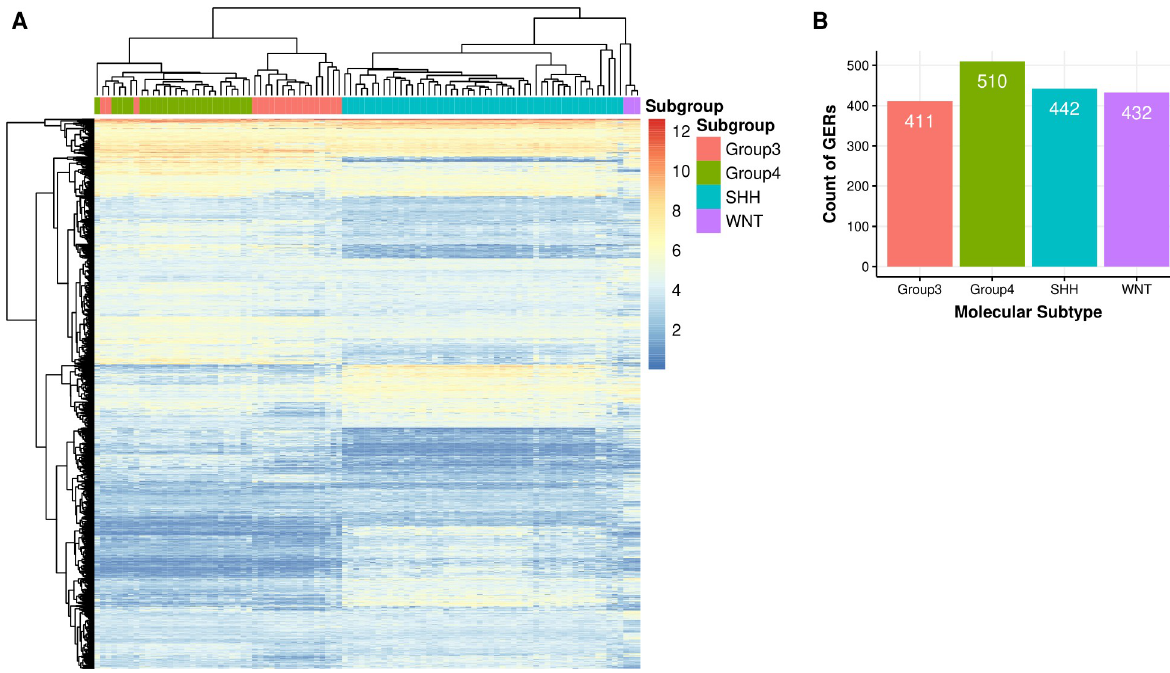
Fig 2. Top genes and GERs representing each Medulloblastoma subtype. A. Heatmap of 1,399 genes associated with 4 molecular subtypes across 97 primary MB samples (RNA-seq: EGAD00001001899). B. Bar chart showing count of 1,795 selected GERs associated with each MB molecular